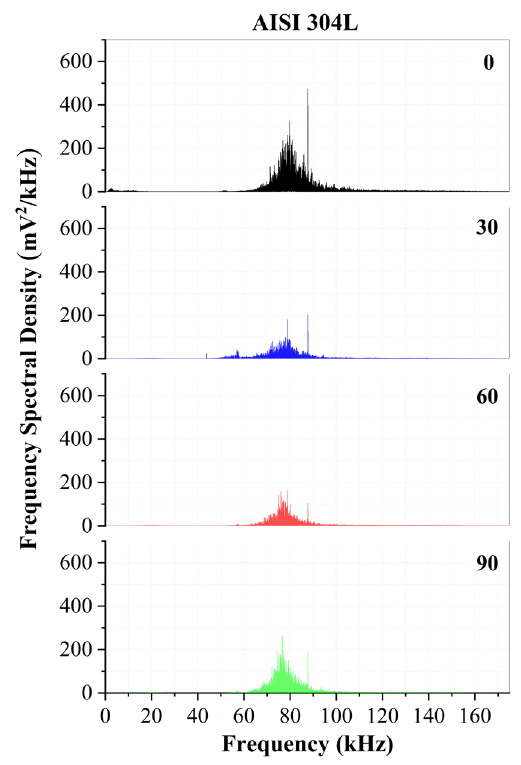
Figure 10. Frequency spectral density for 304L steel. Figure 11. Damping profile for 201LN and 304L